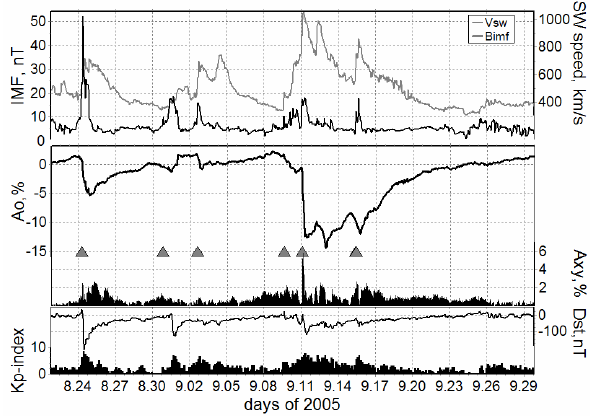
Figure 1 : Parameters of the solar wind (upper panel), density (A0) and anisotropy Fig. 1. Parameters of the solar wind (upper panel), density (A0) and (Axy) of the 10 GV CR (mid panel), and Dst and Kp indices of geomagnetic anisotropy (Axy) of the 10GV CR (mid panel), and D st and K p activity as well (lower panel) in August-September 2005. “SSC” corresponds to the moment of a shock arrival at the Earth. indices of geomagnetic activity as well (lower panel) in August– September 2005. “SSC” corresponds to the moment of a shock arrival at the